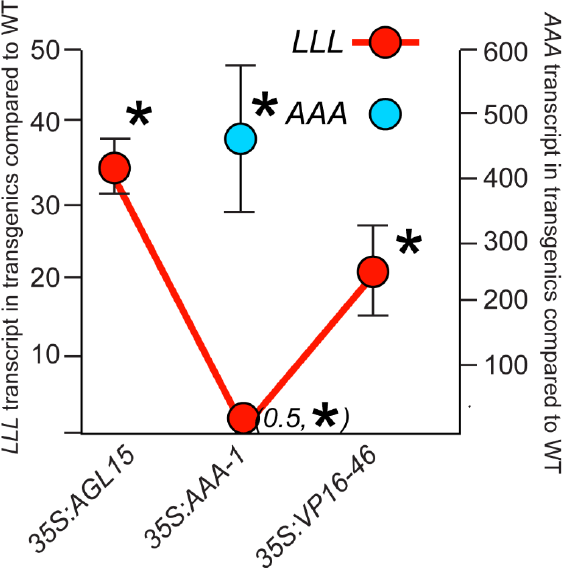
Figure 2. Transcript accumulation from the AGL15 transgenes and the endogenous AGL15 gene. Accumulation of AGL15 transcript in the transgenics is compared to Col wt (set to 1). The primers that amplify the LxLxL form will hybridize to transcript from the endogenous gene as well as transcript from the 35S:AGL15 and 35S:AGL15-VP16 transgenes. The primer that hybridizes specifically to the AxAxA form does not amplify the LxLxL form. Oligonucleotide primers used are presented in Table S1. Results are means and standard error of the mean from four biological replicates assessing transcript accumulation in 10–12 d SAM SE tissue. * indicates a significant difference at p < 0.05 as assessed using a Student’s t -test. Numbers in parentheses indicate fold change compared to Col wt for comparisons difficult to see on the scale shown. ns, not